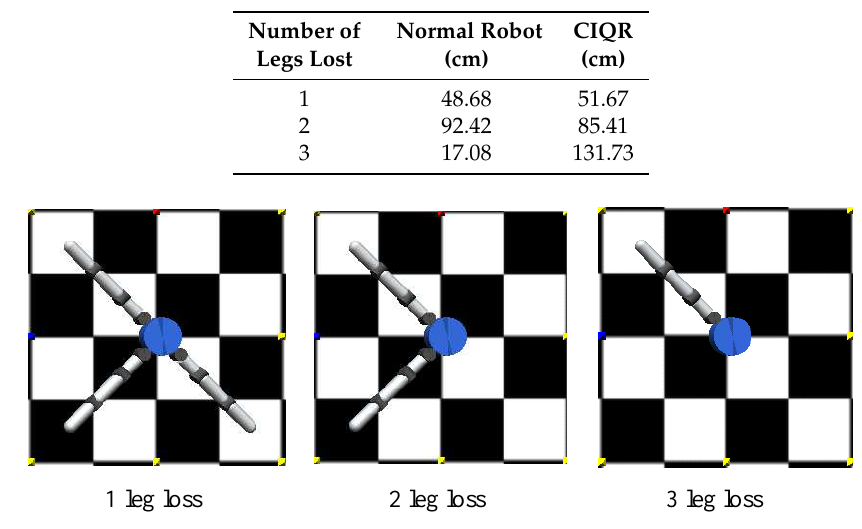
Figure 17. Test cases of damaged robots.